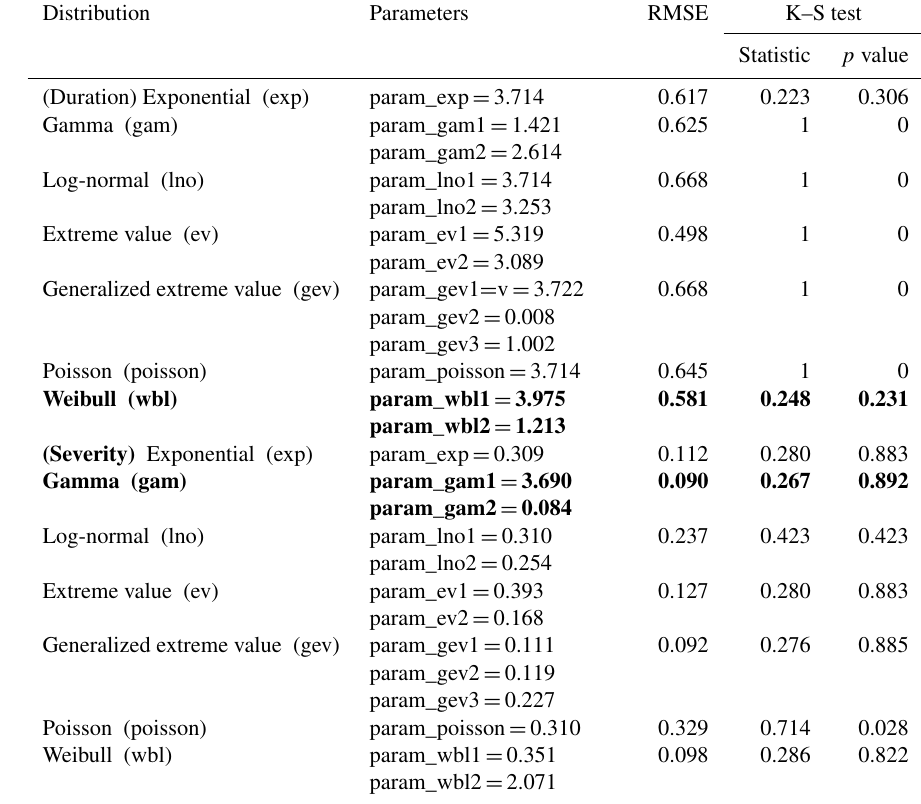
Table 3. Parameters and goodness-of-fit values of the marginal distributions. The best fitted marginal distributions of duration and severity are marked with bold